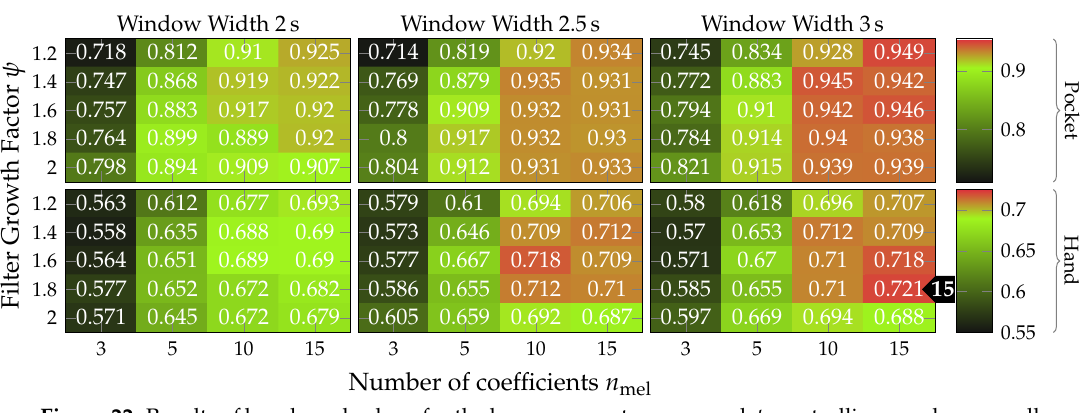
Figure 21. Results of hyperparameter benchmarks for MFCC features. ( a ) shows a statistical analysis of the accuracy distributions for different hyperparameters, dependent on case and whether normalization was used for the filter-bank. ( b ) shows the accuracies reached as a function of hyperparameters n mel and ψ , averaged across the tested window lengths for both pocket-case and hand-case.